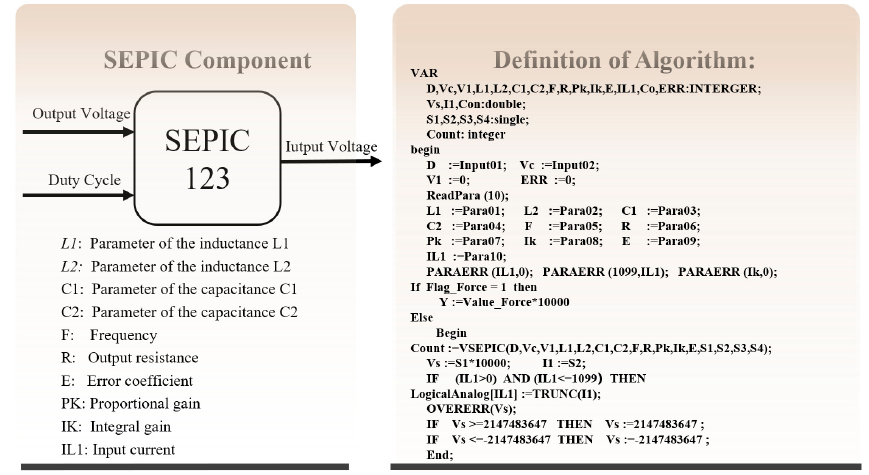
Figure 7. The definition of algorithm and parameters of SEPIC component.